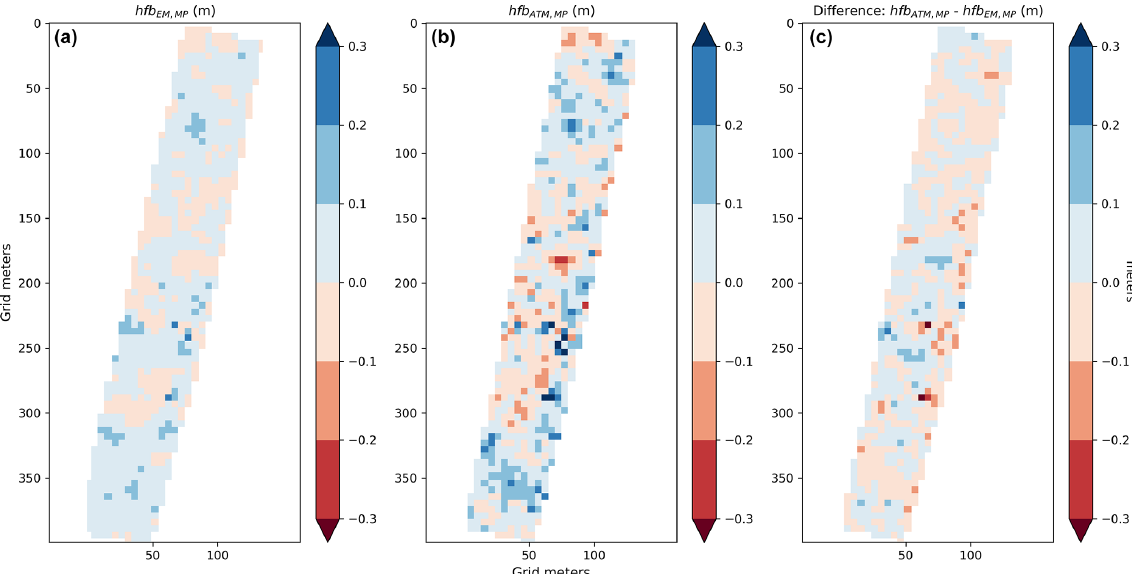
Figure 7. Ice freeboards (hfb) over the survey site: (a) hfb EM , SP computed using Eq. (3) with EM and snow probe data gridded at 5m;